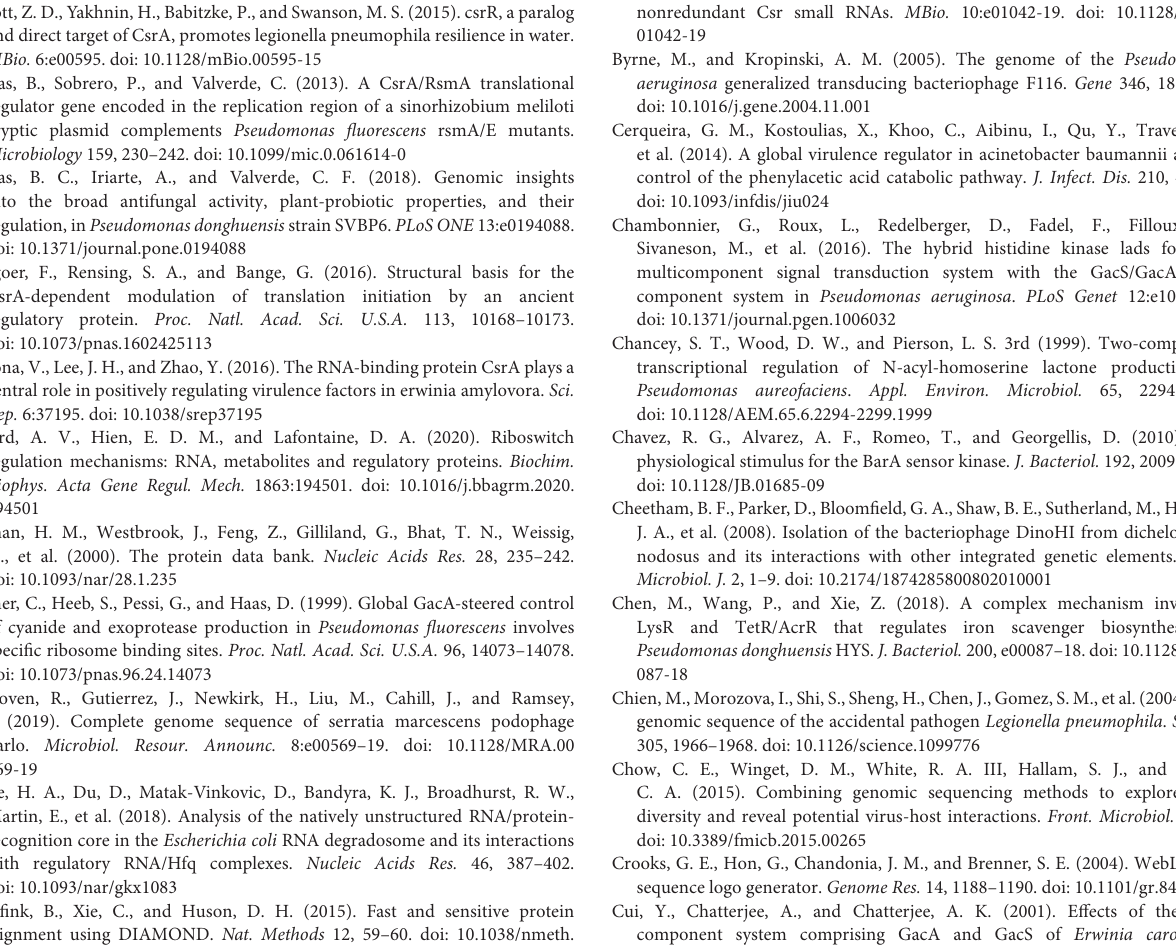
inference approach based on the analysis presented in Figure 6 . Each sequence was evaluated under the same phylogenetical analysis to assign it into an Rsm subfamily. Supplementary Table 5 | Distribution of Rsm paralogues in the major Pseudomonas taxonomic subgroups. The table details the presence of an allele of each different Rsm subfamily in the genome of the Pseudomonas species and strains listed in Supplementary Table 4 . Supplementary Table 6 | CsrA homologs in natural plasmids. The unpublished csrA alleles in natural plasmids were identified with the tBLASTn tool of the query coverage of 30%. Supplementary Table 7 | CsrA homologs in phages. The unpublished csrA alleles in natural phages were identified by querying the NCBI non-redundant protein database with PSI-BLAST using the E. coli CsrA sequence as a bait and narrowing the search to the Viruses taxid:10239 (accessed on April 2, 2020). After 10 iterations, the hit list reached a plateau with 30 identified